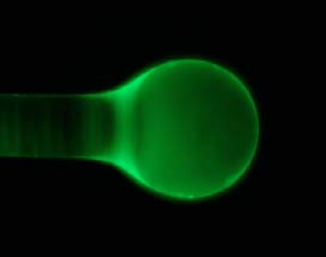
Figure 2. Fluorescent image of the sample